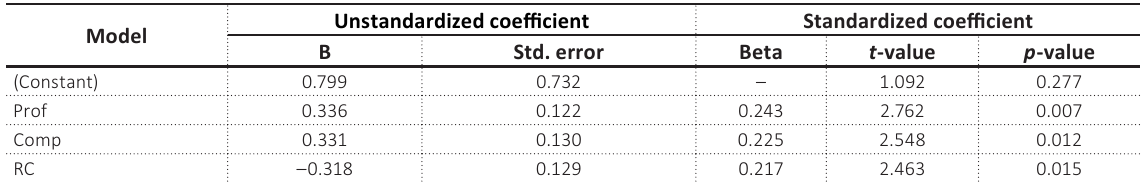
Table 2. p -value and t -value for Hypotheses 1, 2, and